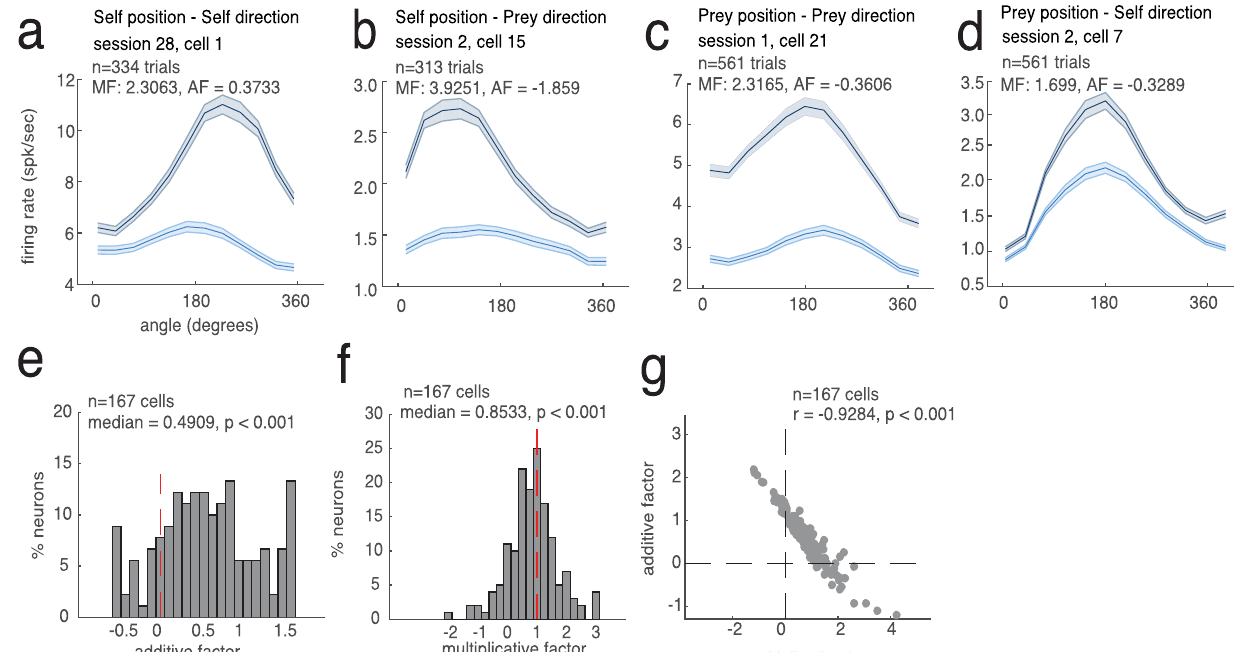
Fig. 6 Mixed selectivity. We illustrate our fi ndings on mixed selectivity by focusing on relative angle. See supplement for other variables. a – d Angular tuning curves for example neurons that showed signi fi cant mixed selectivity. Horizontal axes re fl ect angle between self and prey; 0 indicates heading toward the prey. Neurons show angular selectivity that is modulated by anticipated reward. Gray line: high-value prey. Blue line: low-value prey. a Multiplicative in fl uence of self direction by self position, b self direction by prey position, c prey direction by self position, and d prey direction by prey position. The error bands are connection of standard deviation in each data point. Each error bars are standard deviation for 1000 times of bootstrapping the neurons. e , f Additive ( e ) and multiplicative ( f ) factors of population. AF>0 indicates additive interaction; MF deviates from 1 indicates multiplicative interaction. g Relationship between MF and AF. Negative correlation indicates that neurons with multiplicative interaction are less likely to have additive interaction.